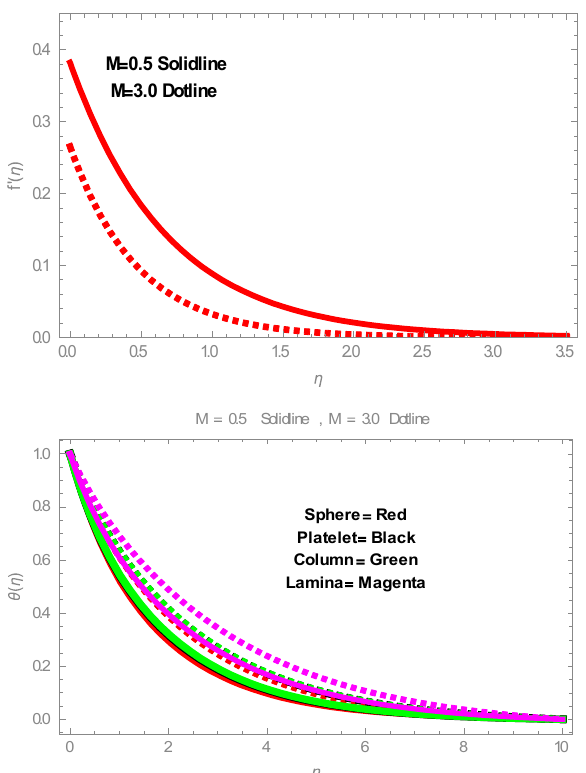
Figure 2. (cid:2016)(η) for shapes of nanoparticles.